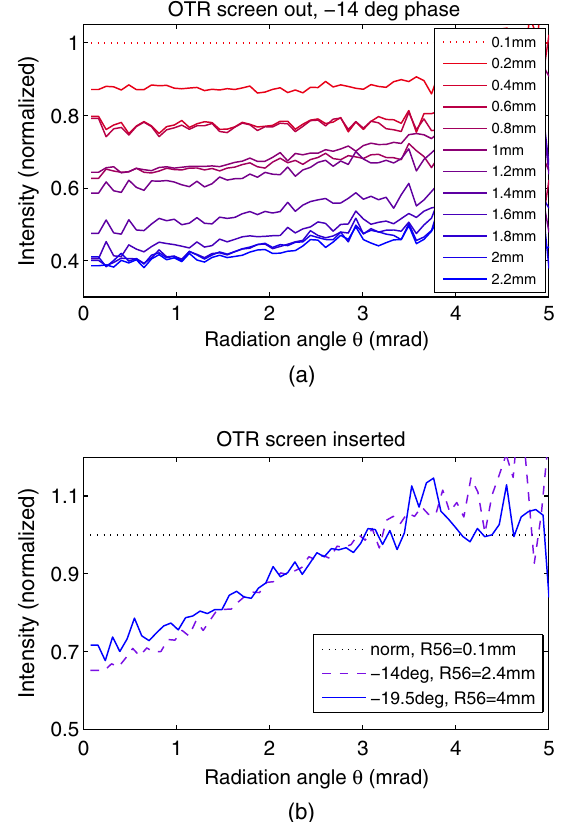
FIG. 5. Radiation intensity as a function of angle from direction of motion normalized by the measurement with R 56 ¼ 0 . 1 mm. (a) Case of − 14 deg gun phase for different values of R 56 . Suppression is slightly stronger on axis, but is relatively uniform across the FWHM beam (2 mrad). (b) Inserting an OTR screen increases emittance, which amplifies angular effects. At optimal suppression for both − 14 deg and − 19 deg gun phases, the degree of suppression is angle dependent, with suppression predominantly on axis. Data for the − 14 deg case corresponds to the red square, R 56 ¼ 2 . 4 mm in Fig.